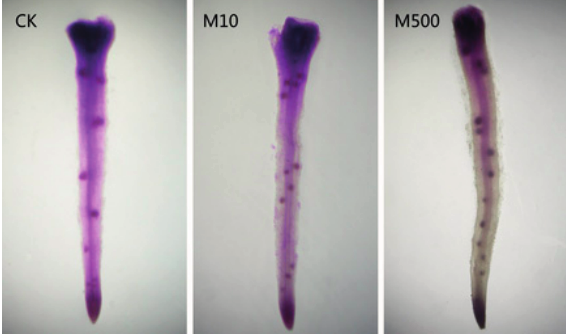
Figure 10. Feulgen stained cucumber roots reveal lateral root primordia (dark points). Melatonin at concentrations of either 10 µM (M10) or 500 µM (M500) stimulated lateral root primordia over the number seen in control roots (CK). From Zhang et al. [183] with